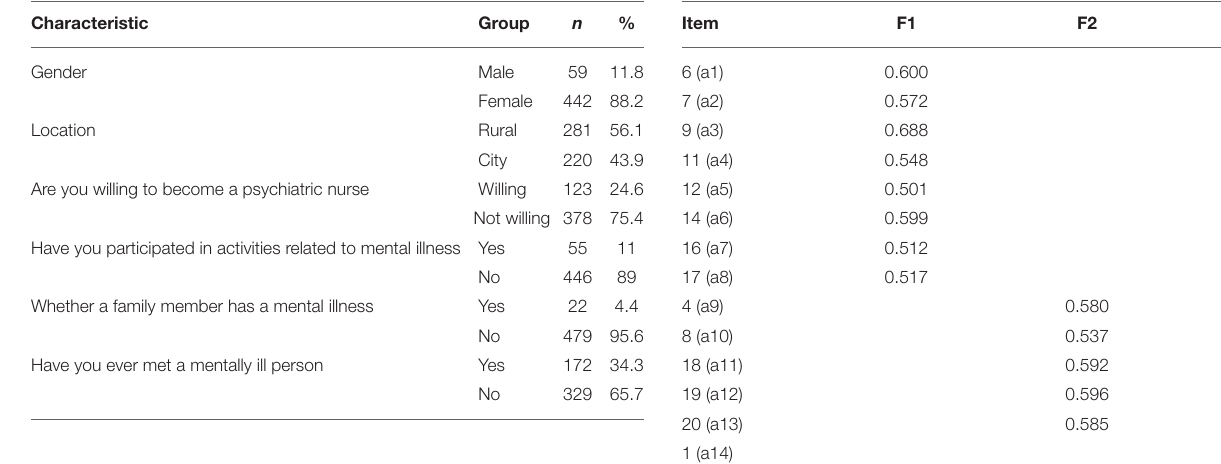
TABLE 1 | Participant characteristics. TABLE 2 | Factor loading of each item in the Chinese version of the